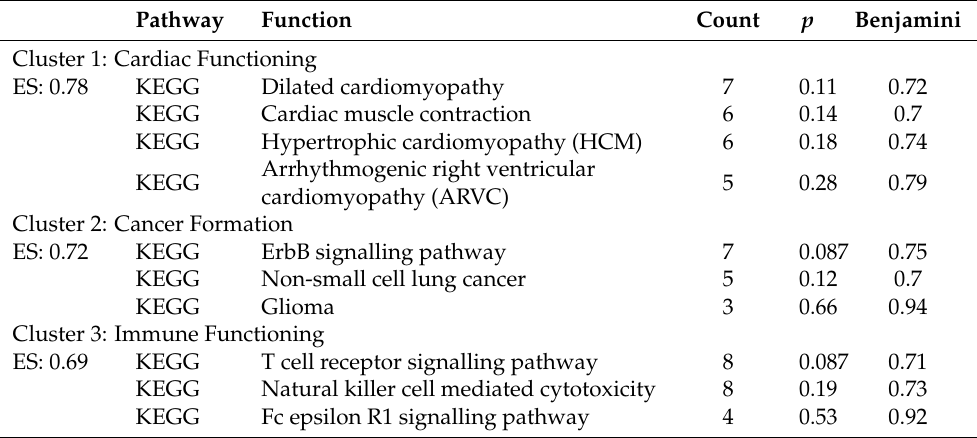
Table 3. Gene functional clusters of the 1000 highest ranked probes associated with the ROLO intervention/control group.